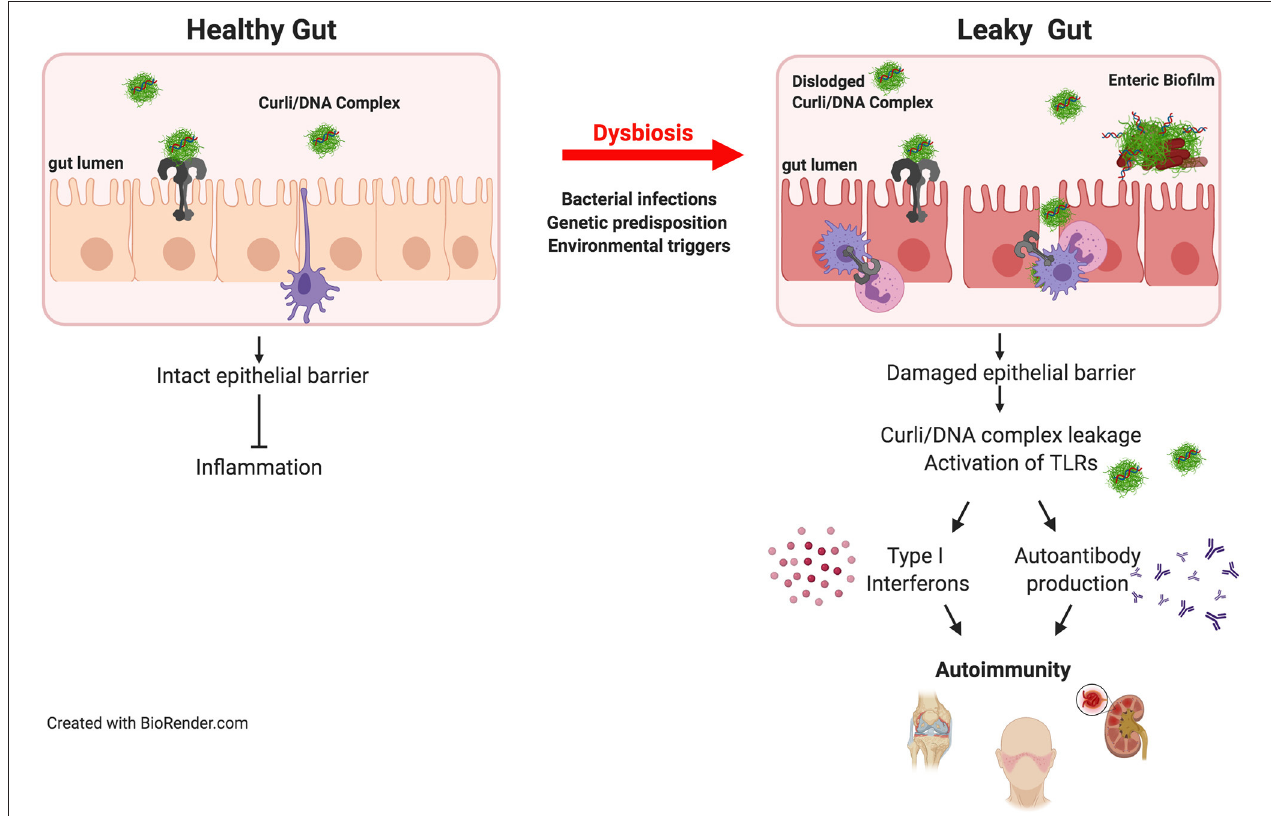
FIGURE 1 | Bacterial amyloids and autoimmunity. Amyloids are produced by the members of gut microbiome. Curli/DNA complexes produced by commensal bacteria are recognized by TLR2/TLR1 heterocomplex which dampens inflammation in healthy intestinal tract. However, when the epithelial barrier is damaged during invasive infections or by other environmental factors or diseases, dislodged curli/DNA complexes from the biofilm activates TLR2/TLR1 heterocomplex and TLR9 leading to the generation of type I interferons and autoantibodies resulting in initiation and exacerbation of autoimmunity. In genetically predisposed individuals, the autoimmune effects of the curli/DNA complexes will likely to be